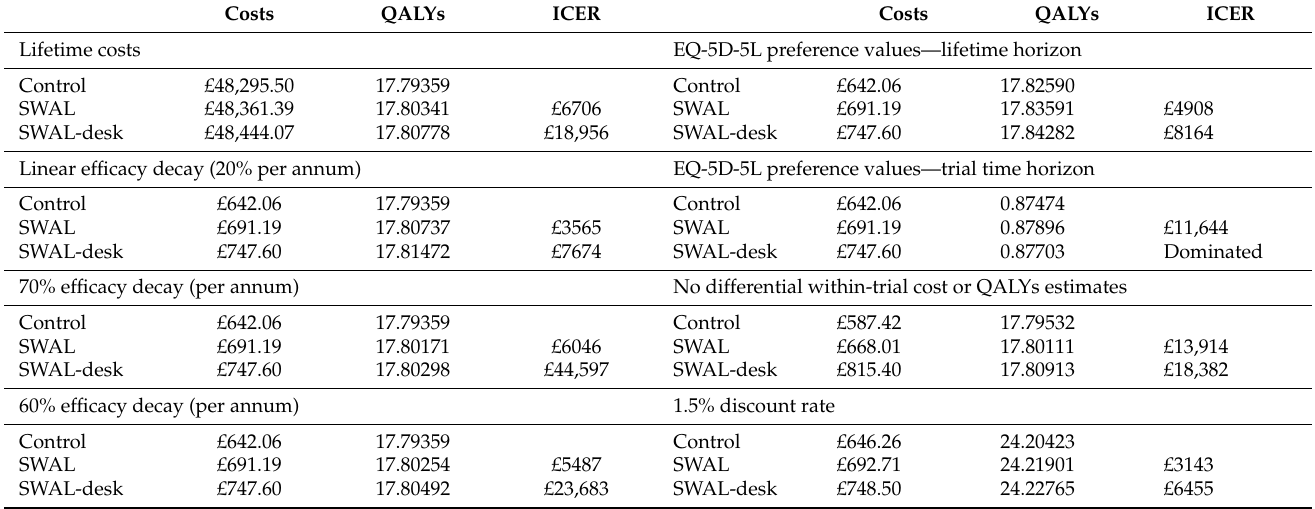
Table 2. Scenario